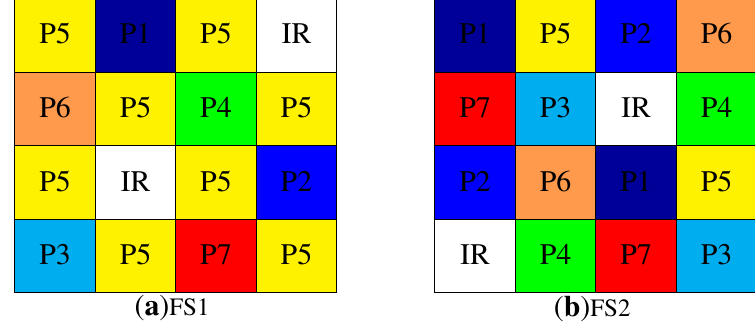
Figure 11. FS1 ( a ) and FS2 ( b ) are two different moxels. FS1 shows an ad hoc distribution with over-sampled channels (P5 and NIR), FS2 shows uniformly distributed samples as an instance of Miao et al. ’s [44] binary tree algorithm. Refer to Figure 10c for the spectral characteristics of the filter